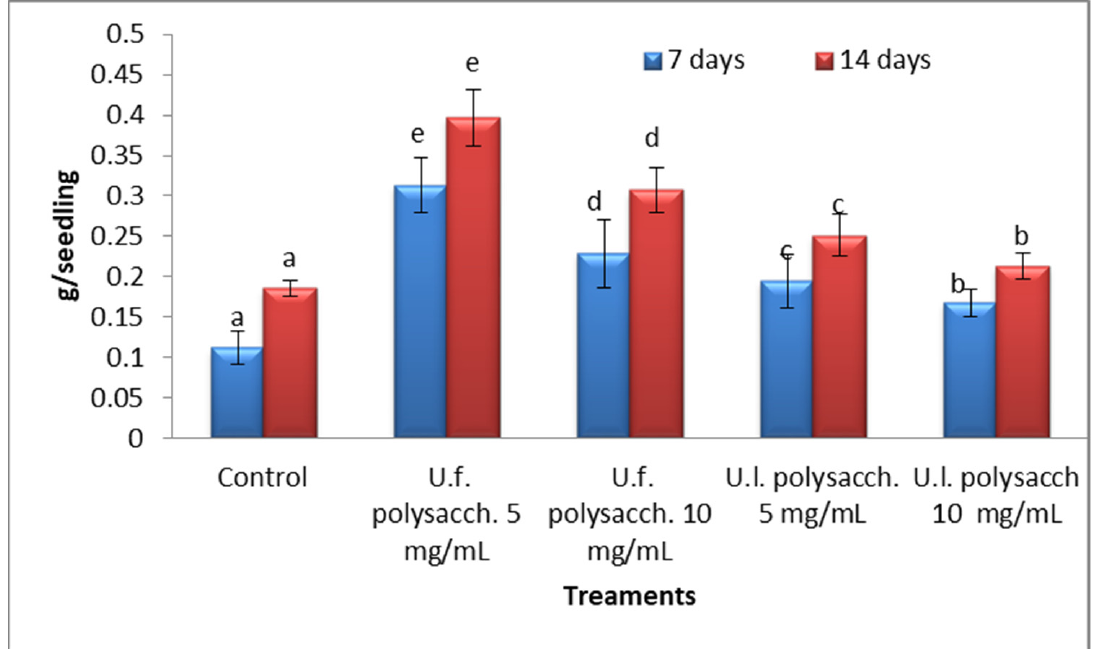
Figure 8. Effect of seed priming with different concentrations of soluble polysaccharides on the dry weight of growing seedlings of Zea mays, as determined at 7- and 14-day intervals during the germination period. The bars represent the standard error (different letters denote the significant value among the treatments on the same day). U.f., Ulva fasciata; U.l., Ulva lactuca.